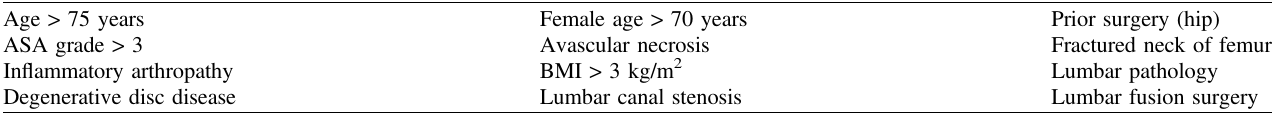
Table 1. Patient risk factors for instability (ASA; American Society of Anaesthesiologists; BMI: Body mass